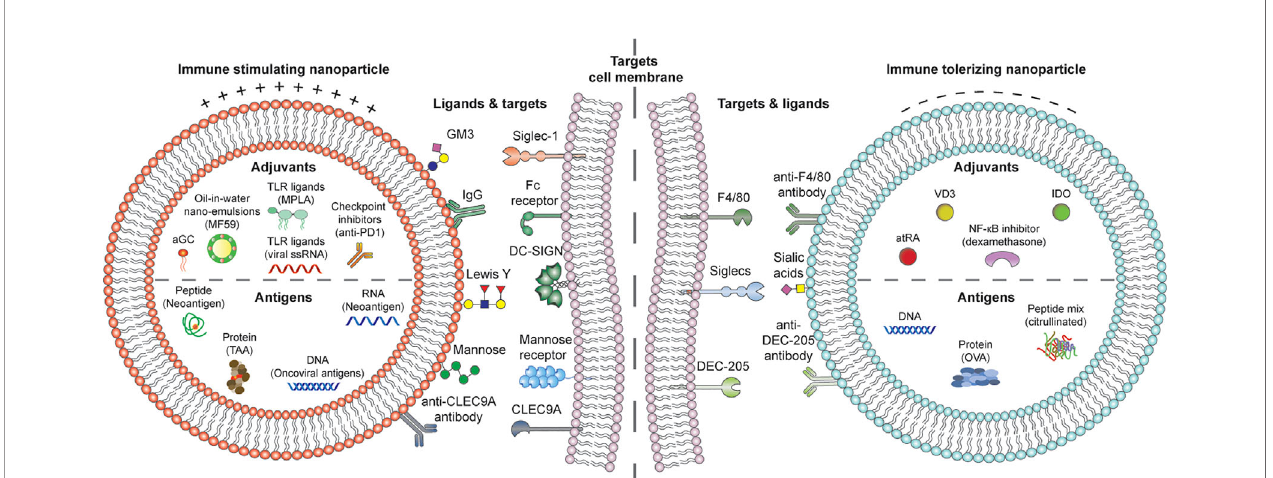
FIGURE 2 | Putative DC-activating cationic (left) or DC tolerizing anionic (right) liposome platforms incorporating disease-speci fi c RNA, DNA, peptide or protein antigens, DC targeting molecules for activation or tolerance, and adjuvants for shaping pro-or anti-in fl ammatory DCs. a GC, a -galactosylceramide; TLR, toll-like receptor; IgG, Immunoglobulin G; DC-SIGN, Dendritic Cell-Speci fi c Intercellular adhesion molecule-3-Grabbing Non-integrin; atRA, all-trans retinoic acid; VD3, vitamin D3; IDO,